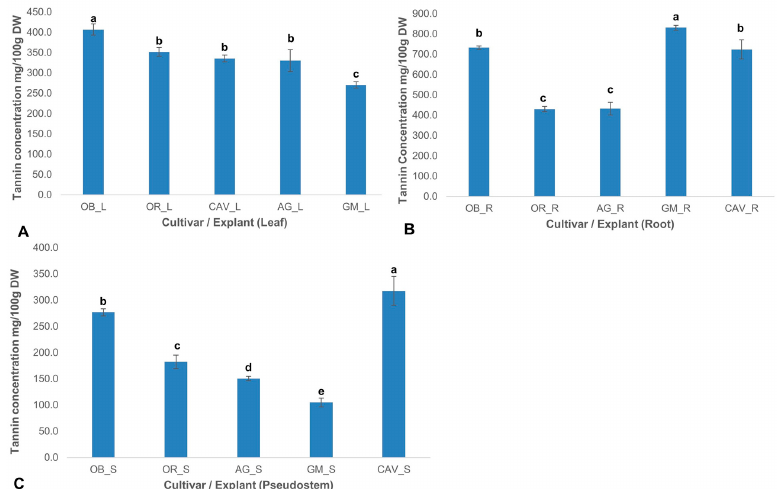
Figure 4. Total tannins in explants of field-grown plants of different cultivars of banana and plantain. (A) Leaf (L) explant; (B) Root (R) explant; (C) Pseudostem (S) explant. Data are presented as means of triplicate samples ( n ≥ 3) and standard deviation. Means with a different letter (a–e) differ significantly from each other at p ≤ 0.0001 (highly significant). OB—Obino l’Ewai; OR—Orishele; AG—Agbagba; GM—Gonja Manjaya; CAV—Cavendish Williams; DW—Dry weight of sample.